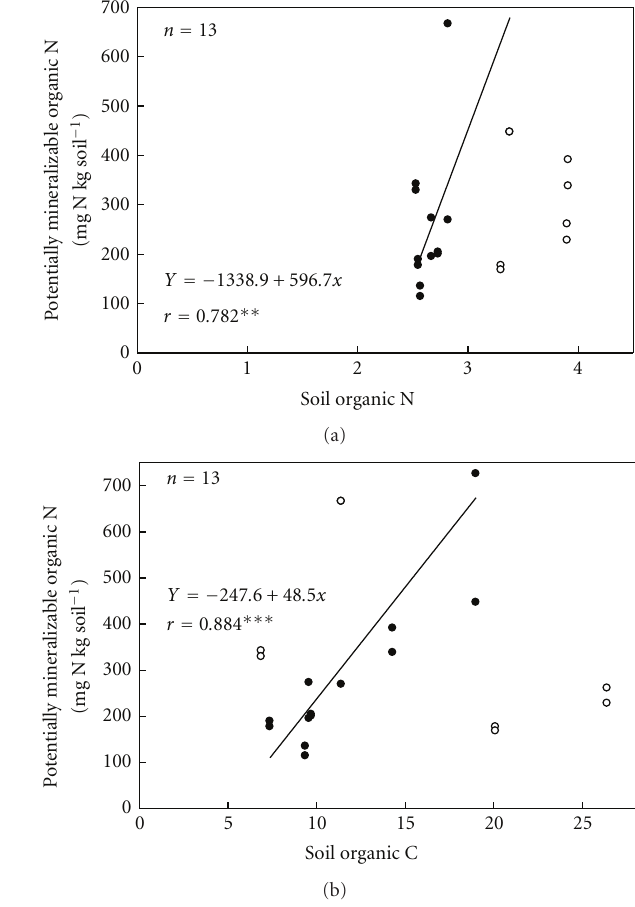
Figure 7: Relationships between potentially mineralizable organic nitrogen (N 0 ) and silt (a), clay (b), and sand (c) contents for soils amended with broiler litter 1 or 2. The open circles did not fit the relationships.